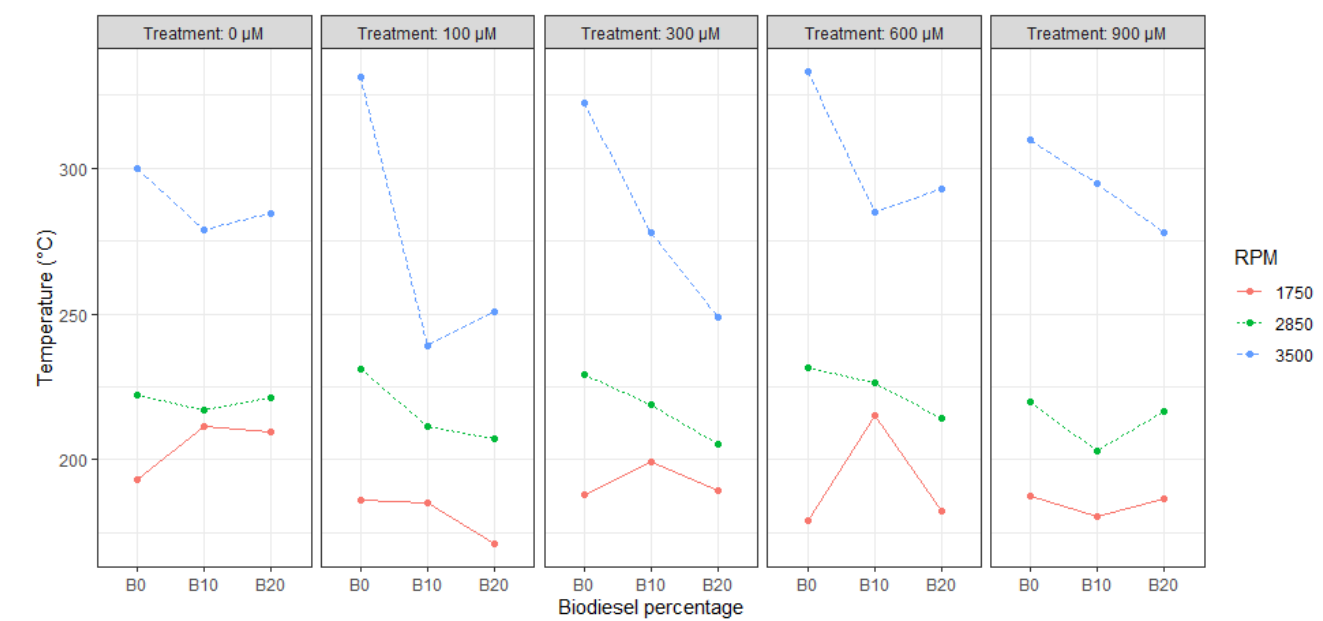
Figure 5. Correlation plot between temperature, SA content, RPM, and biodiesel percentage.